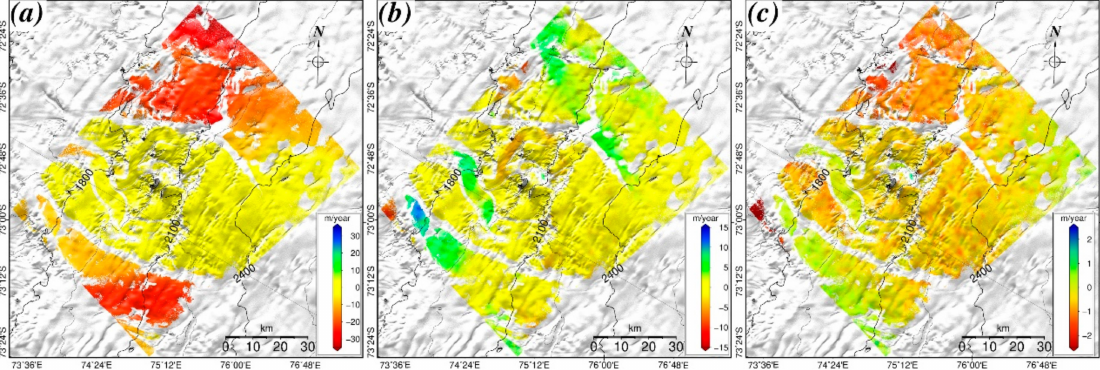
Figure 5. Complete 3D ice velocities in the Grove Mountains area. The ice movements along the east ( a ), north ( b ), and vertical ( c ) directions are superimposed on the topographic map,